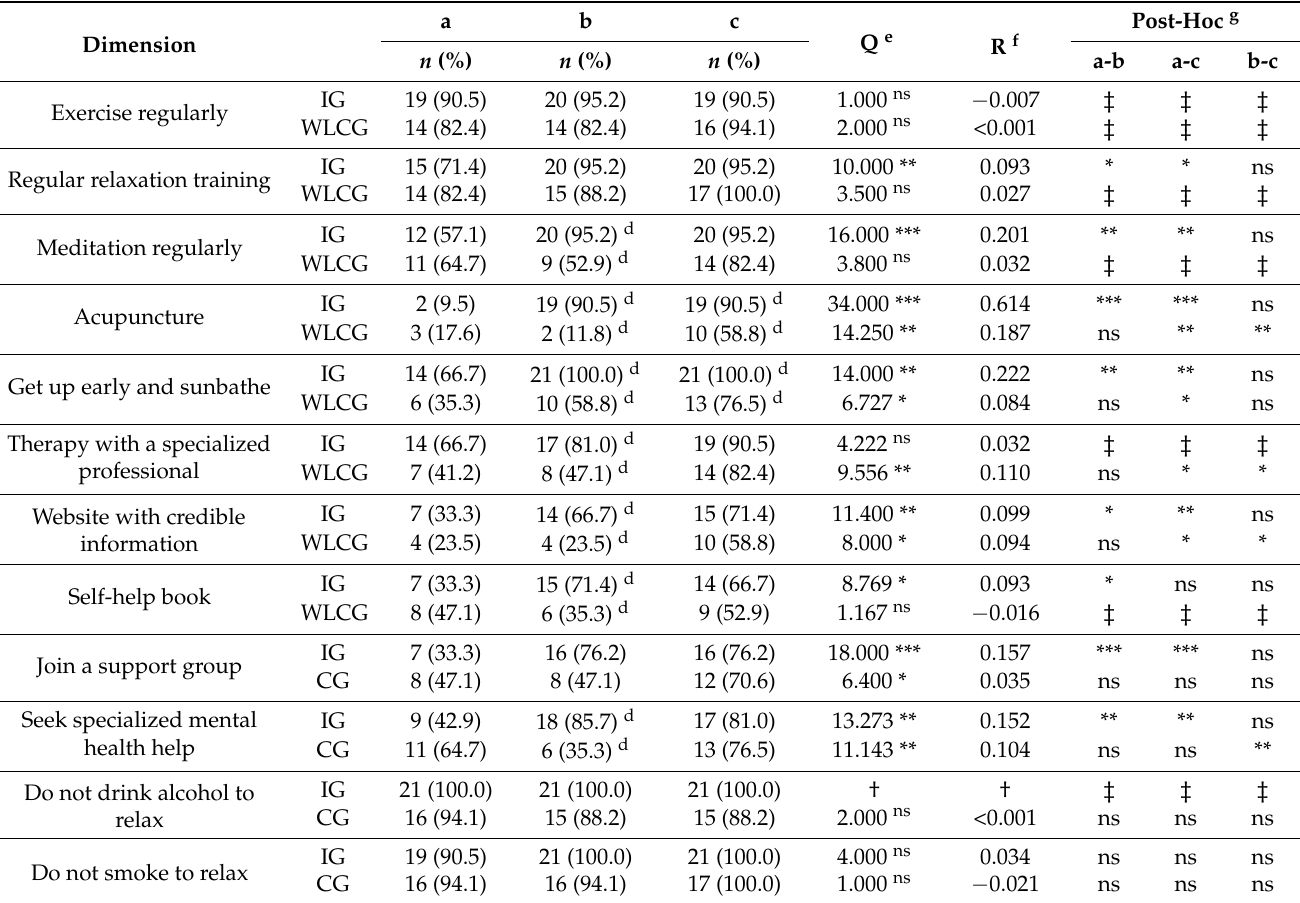
Table 4. Findings for “anxiety self-help strategies” in the three assessments by